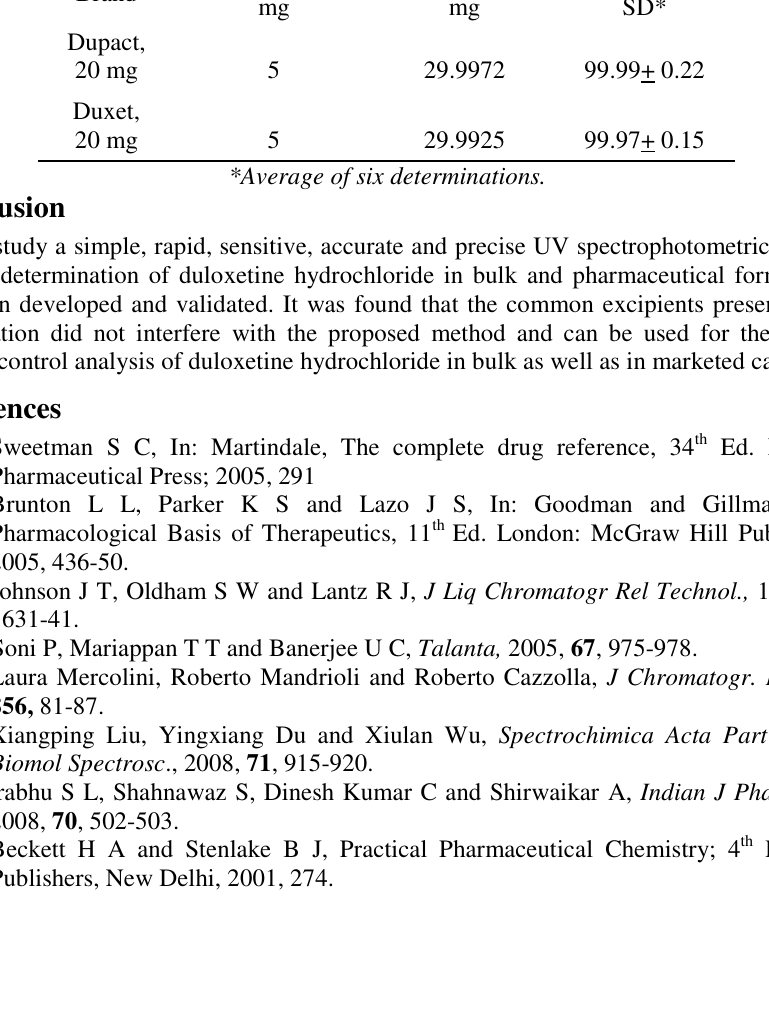
Table 3. Recovery studies of duloxetine hydrochloride capsules. Amount added, Amount found, %Recovery + Brand mg mg SD* Dupact,